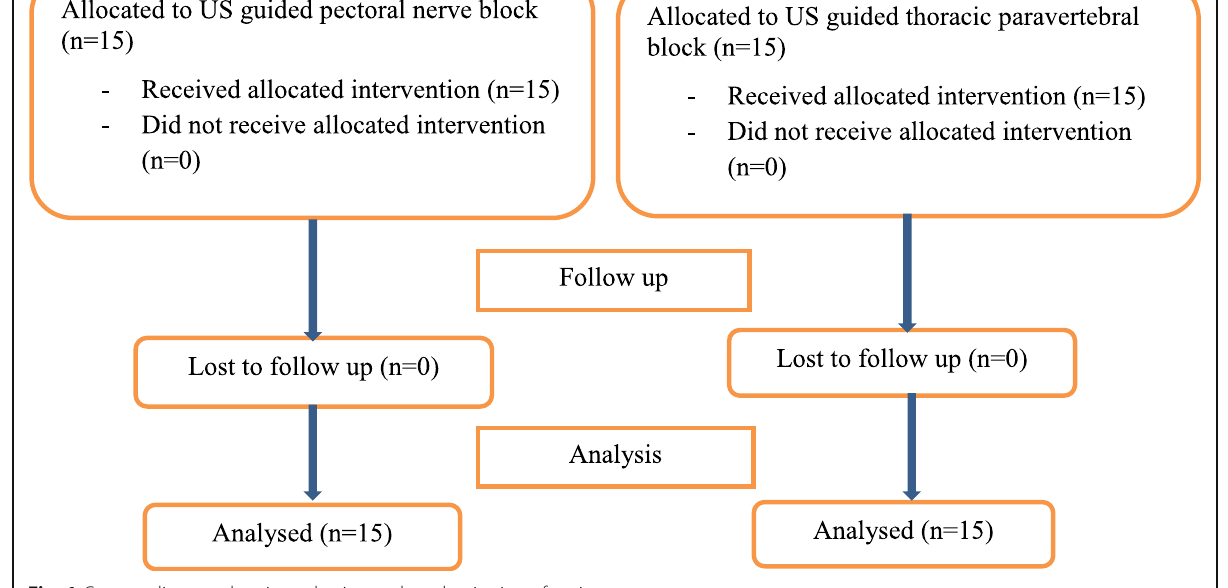
Table 3 Comparison between group A and group B regarding total fentanyl used intra-operatively and in the first 24 h postoperatively and the time needed for the first requested rescue analgesia